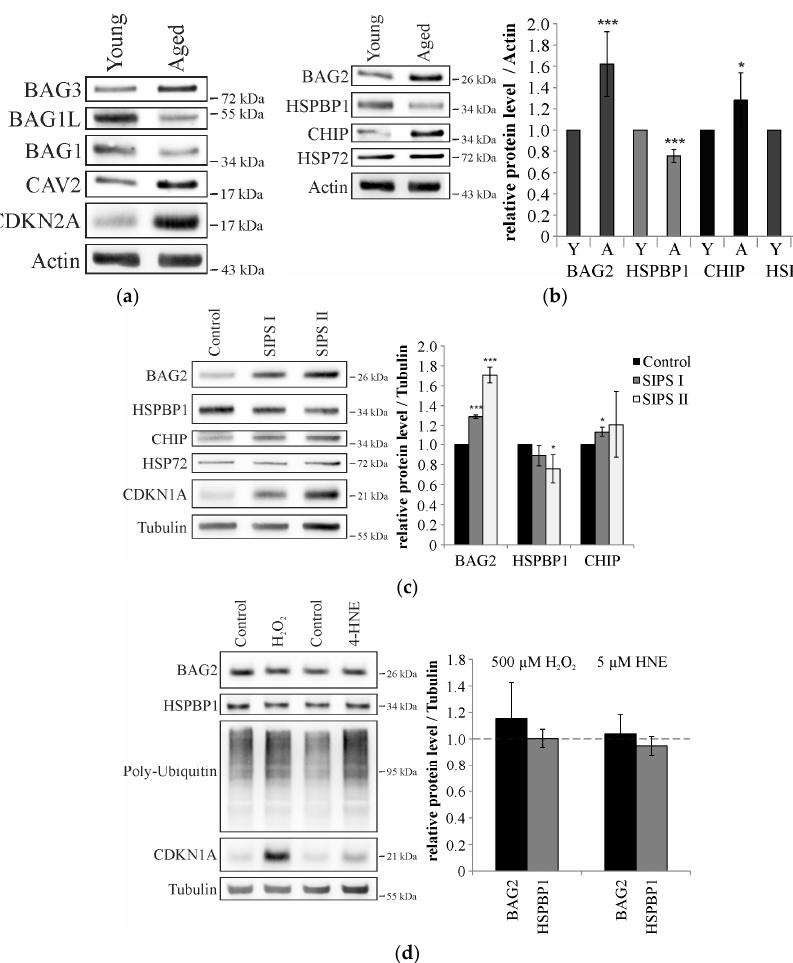
Figure 3. ( a ) Immunoblot analysis of aging marker proteins in young (PDL 20) and aged (PDL + 50) fibroblasts. Actin served as control of equal loading. One representative blot is shown. n = 3; ( b ) Immunoblot analysis of BAG2, HSPBP1, CHIP, and HSP72 in young and aged fibroblasts. Actin served as loading control. Statistics are depicted as mean ± SD. * p < 0.05, *** p < 0.001, n = 4; ( c ) Immunoblot analysis of indicated proteins in young fibroblasts, that were treated repeatedly with 200 µM (SIPS I) and 500 µM (SIPS II) hydrogen peroxide (H 2 O 2 ) to induce premature senescence (SIPS). Tubulin served as loading control. Statistics are depicted as mean ± SD. * p < 0.05, *** p < 0.001, n = 3; ( d ) Immunoblot analysis of BAG2 and HSPBP1 levels in fibroblasts that were treated with H 2 O 2 or 4-hydroxy-nonenal (4-HNE). Poly-Ubiquitin and CDKN1A indicate proteostatic stress. Tubulin served as loading control. Statistics are depicted as mean ± SD. n = 3.